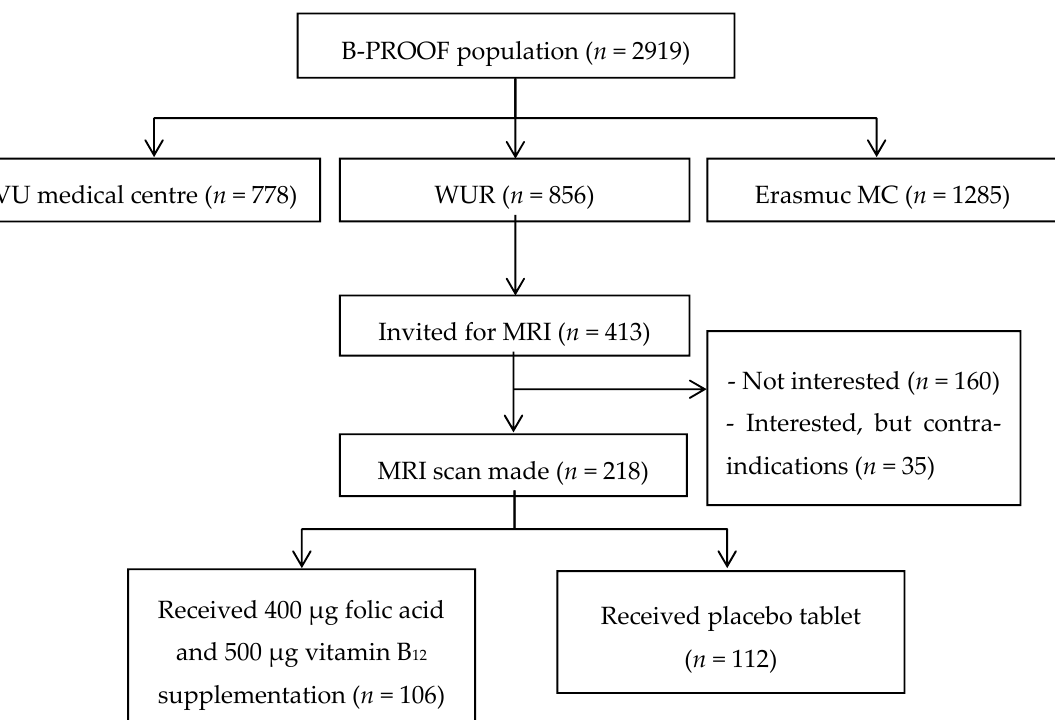
Figure 1. Flowchart of participants that were enrolled in the magnetic resonance imaging (MRI) study, a sub-study of the B-PROOF trial.